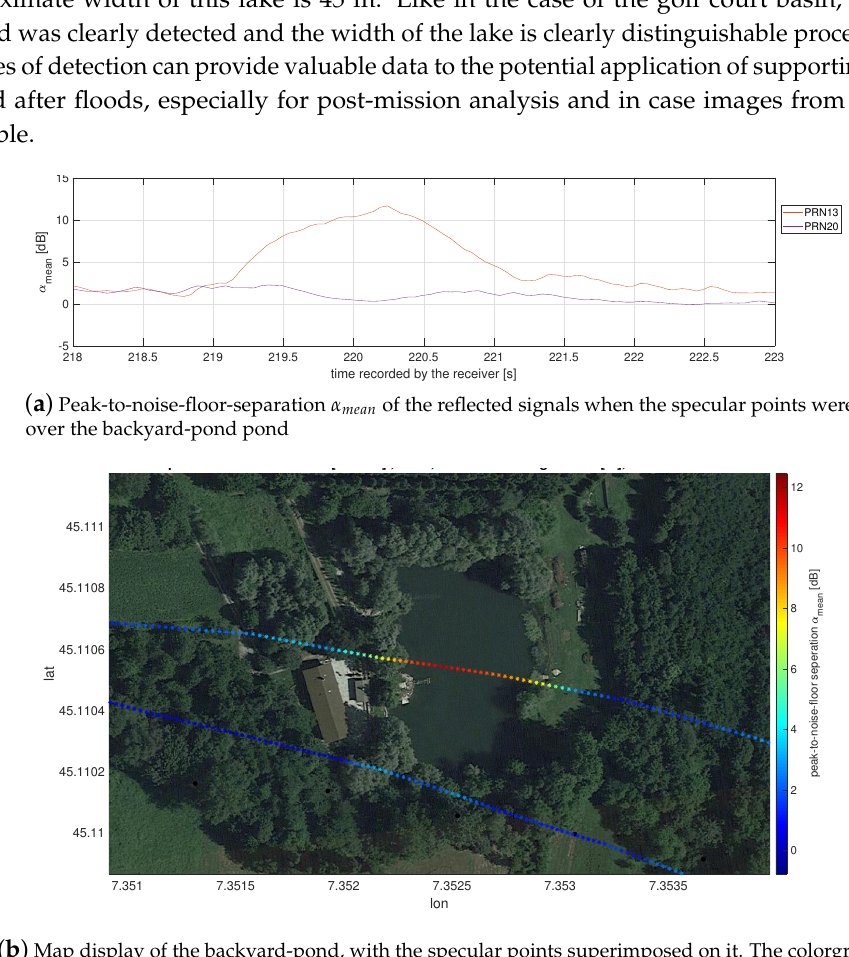
Figure 13. Example of the detection of an backyard pond taken from data set